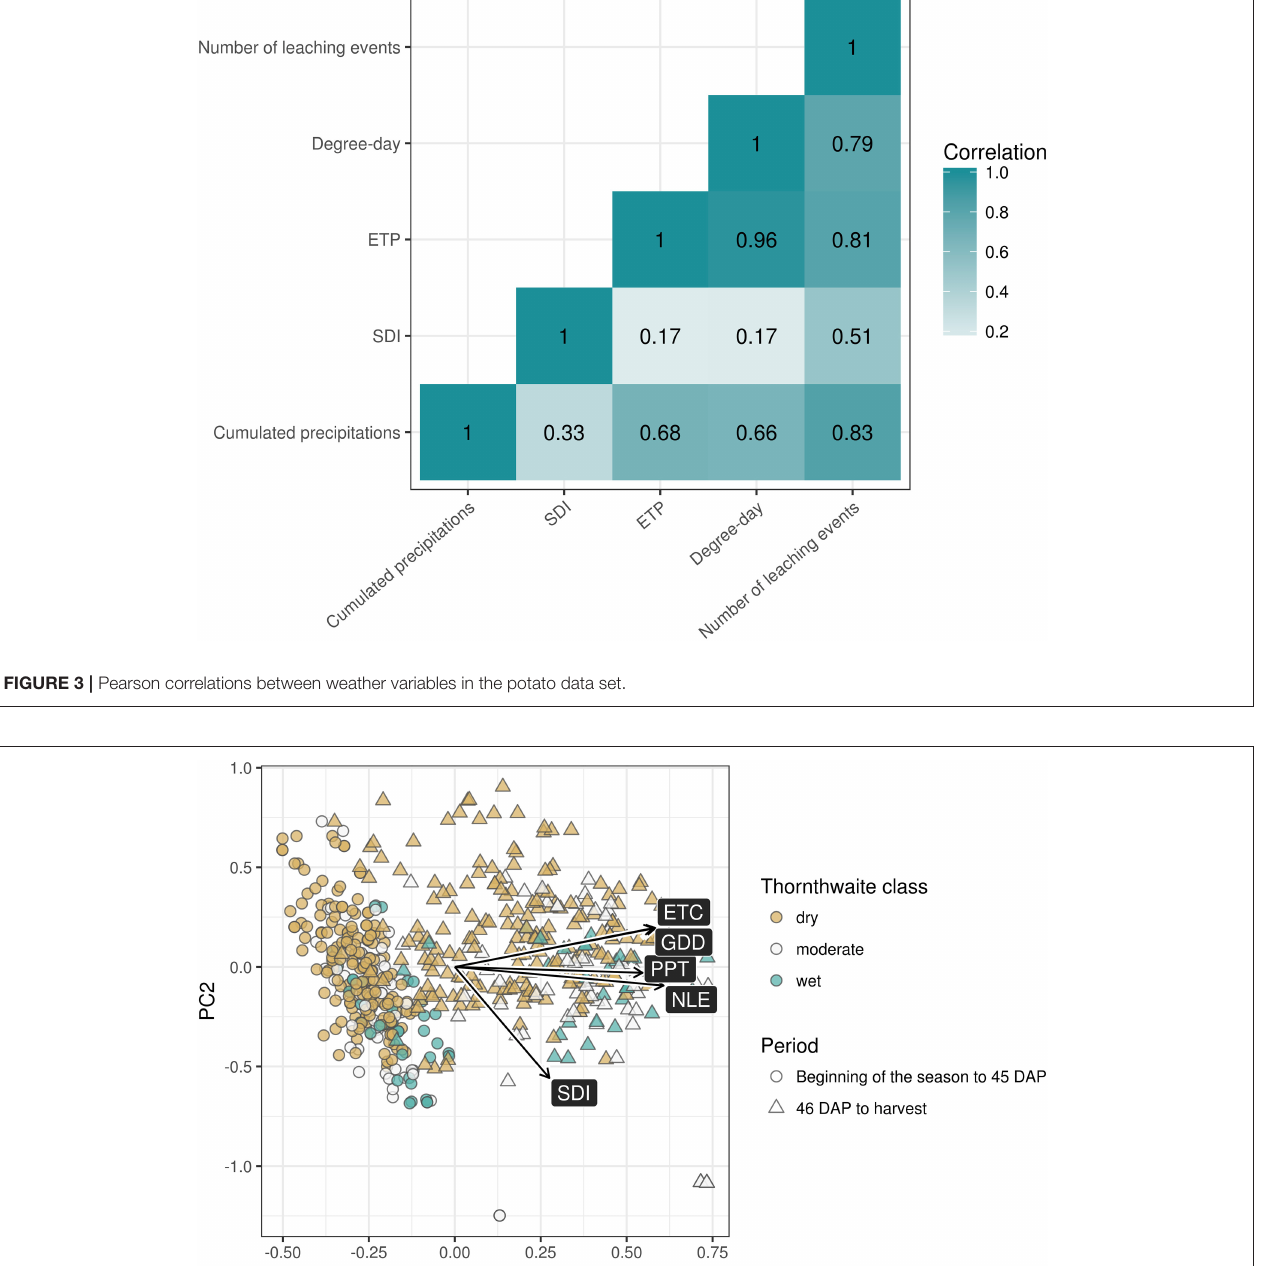
FIGURE 4 | Biplot of the principal component analysis of weather indices (scaling